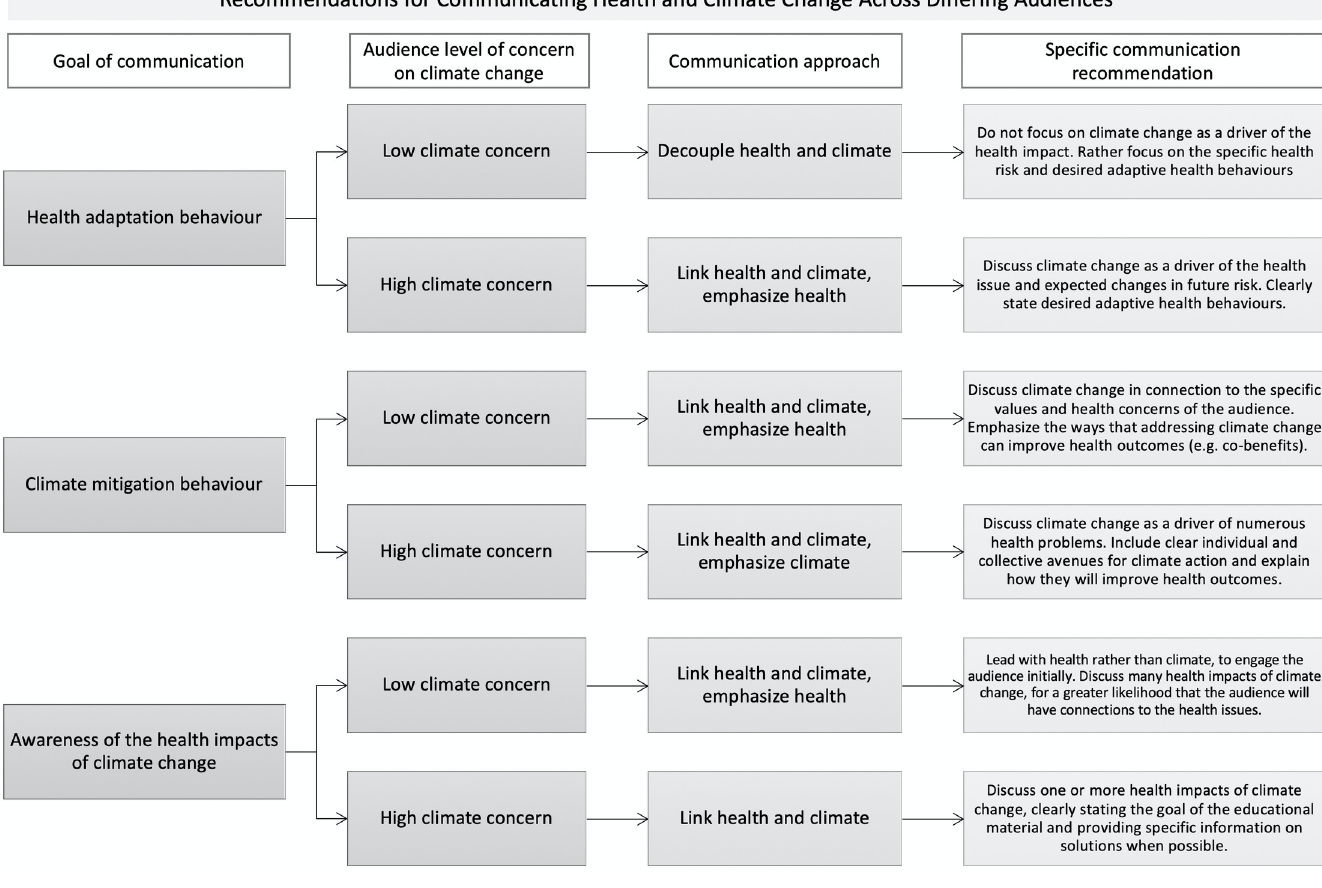
Fig 2. Recommendations for communicating health and climate change across differing